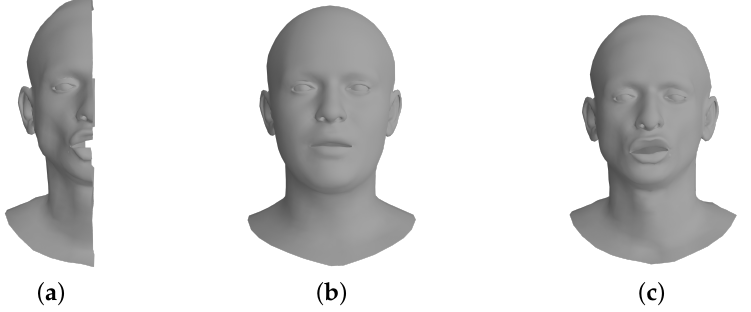
Figure 5. The leftmost mesh shows the partial input mesh ( a ). The initial mesh is obtained by the decoder before performing network optimization ( b ), and the rightmost mesh shows the result obtained from the decoder after the iterative optimization step ( c